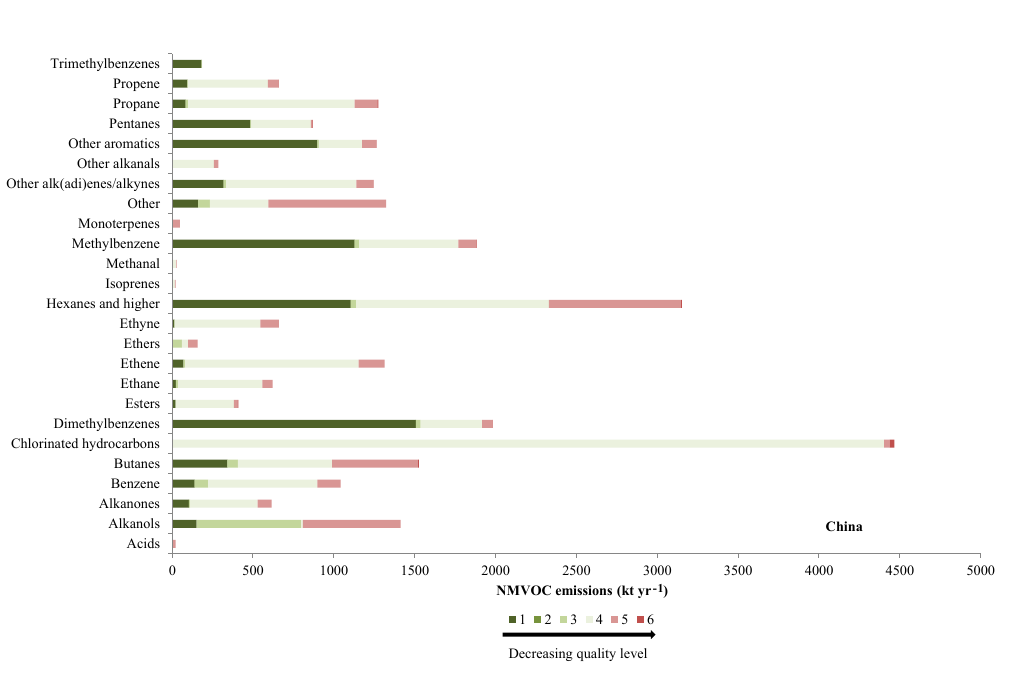
Figure 12. Emissions of 25 NMVOC groups associated with each quality code in 2010 in China.